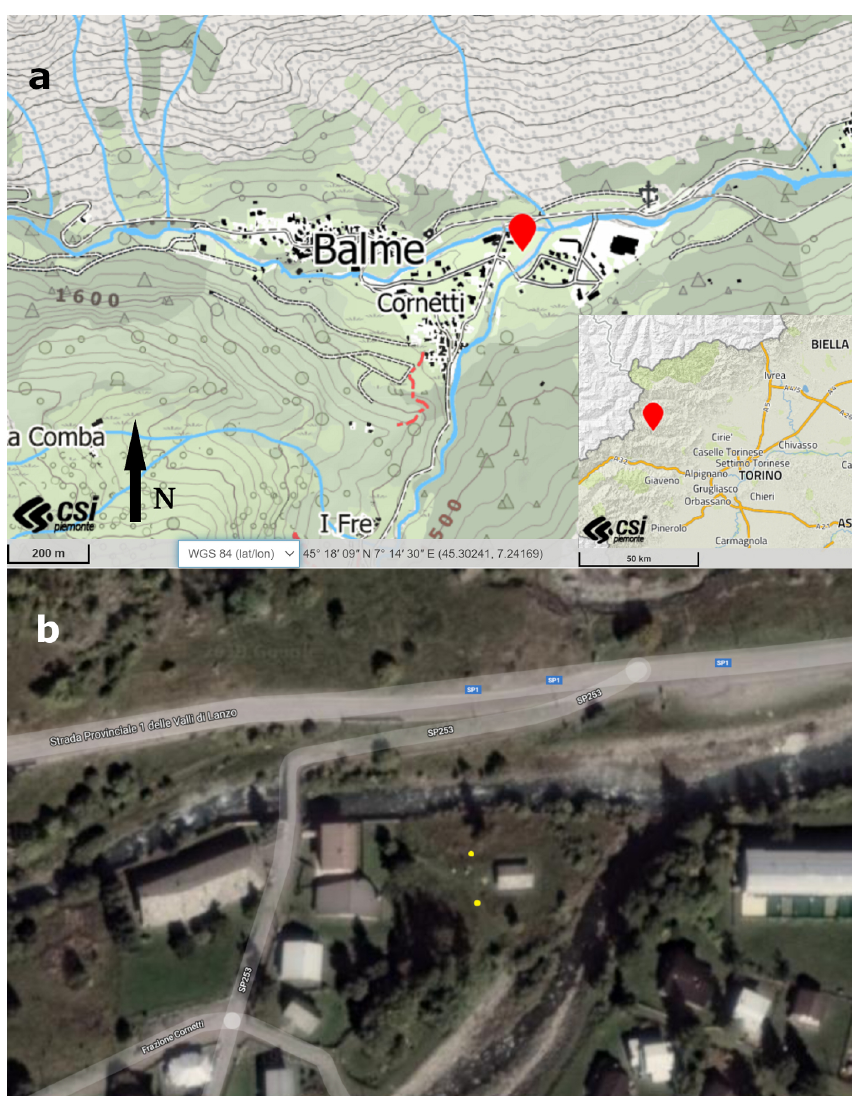
Figure 3. (a) Local topographic map (© Geoportale Regione Piemonte, 2021) of the area ( ∼ 2 × 1.5km) surrounding the measurement site. The Ala Valley is aligned from east–west with mountains close to the valley in the north, while in the south a small lateral valley opens up the horizon to other high mountains. The measurement site is marked with a red inverted teardrop. The inset shows the position of the measurement site in the Western Alps and in relation to Turin. (b) Magnified ( ∼ 200 × 100m) Google Earth (© Google 2017) picture of the experimental site. The approximate positions of the two measurement stations are marked by the yellow